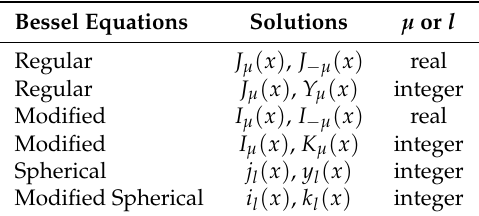
Table 2. The linearly independent solutions of the four Bessel equations (see Table 1). The standard notation commonly adopted in textbooks and monographs of mathematical physics is used for these